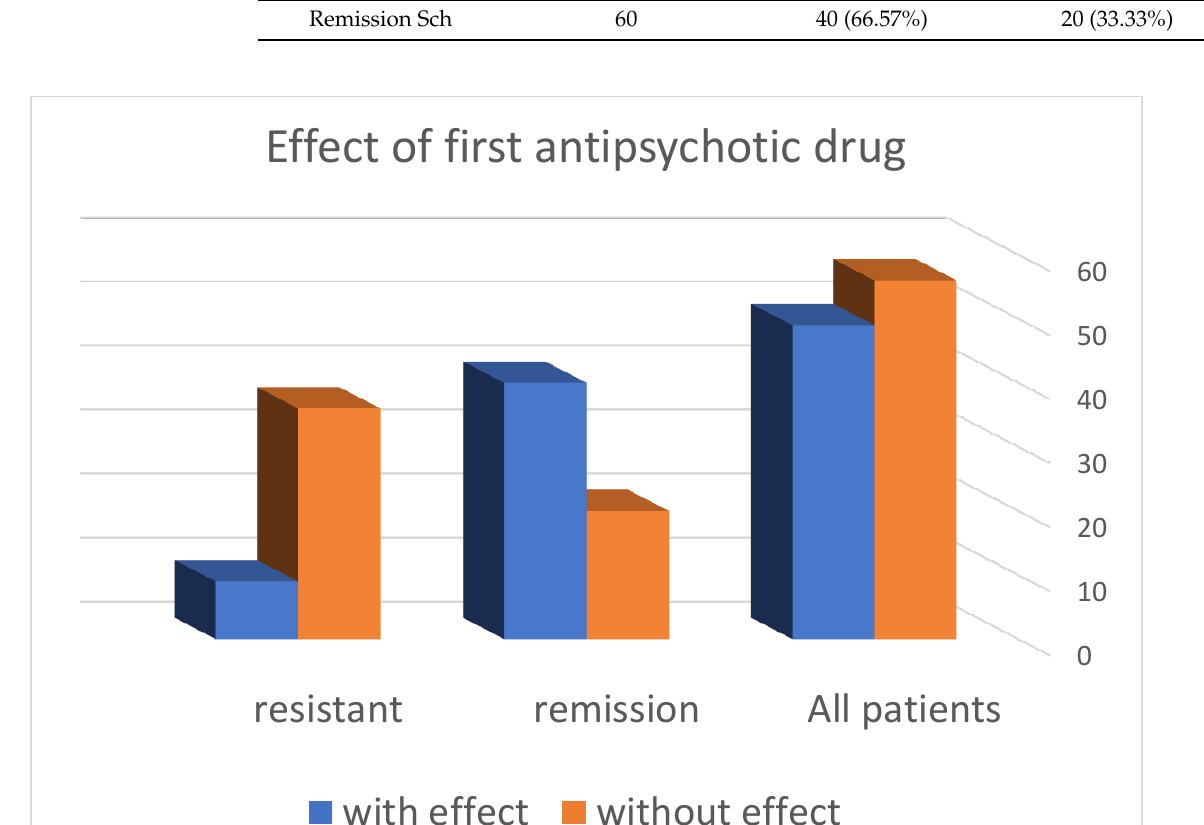
Figure 1. Distribution of patients according to the effect of treatment.